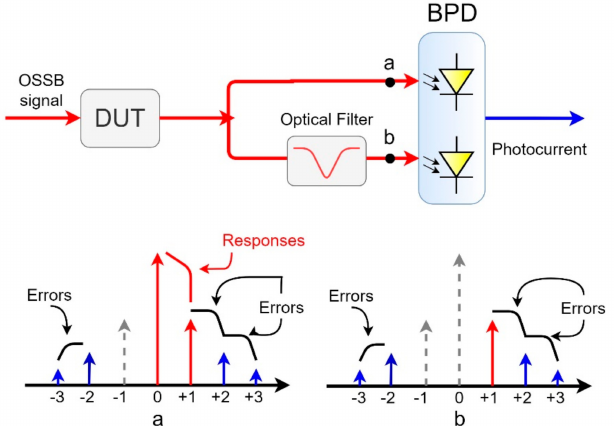
Figure 3. The principle of balanced photodetection: DUT—device under test; BPD—balanced photodetector; red lines—optical signal; blue line—electrical signal (adapted from